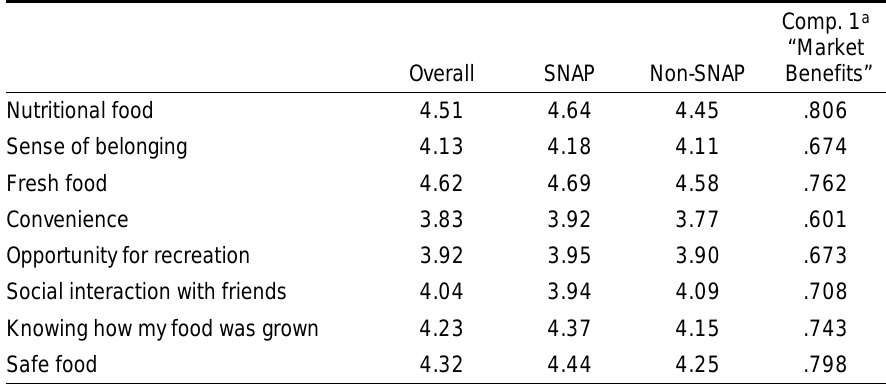
Table 4. Benefits of Attending the Farmers Market (1=strongly disagree